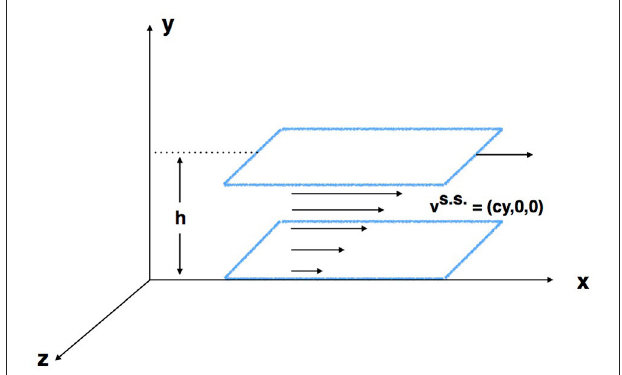
FIGURE 1 | Schematic representation of the 2D plane Couette flow. Two parallel plates are a distance h apart; the steady laminar flow has a linear profile w.r.t. the y coordinate i.e., v s . s . = { cy ,0,0 } . For the semi-bounded case, h → ∞